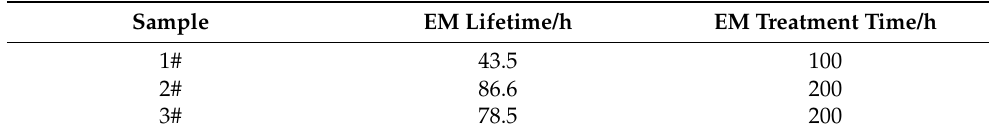
Table 1. EM lifetime and EM treatment time for three test samples.